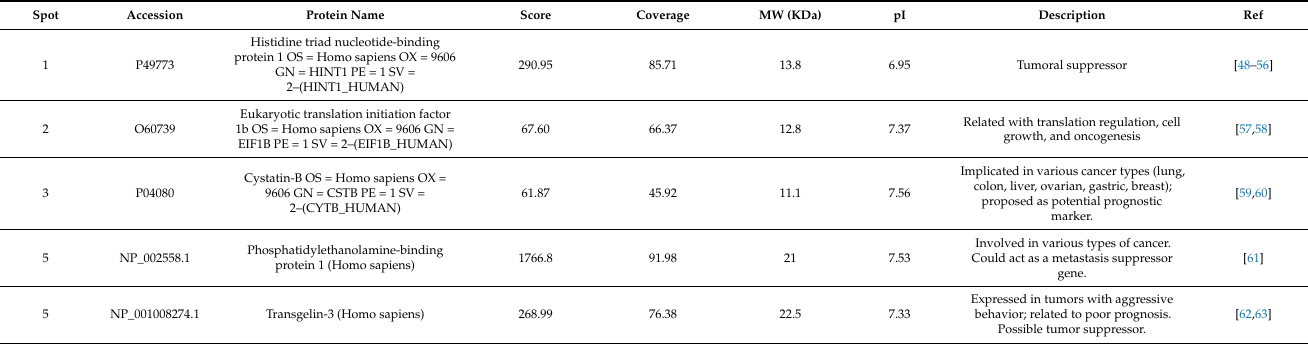
Figure 4. Representative 2DE gels from non-invasive PA ( A ) and invasive PA ( B ). Thirteen spots were selected comparing between all gels. Isoelectric focusing (IEF) was carried out with a 7 cm IPG strip (pH 3–10); second dimension SDS-PAGE (15% polyacrylamide gel). Table 4. Mass-spectrometric identification from the selected